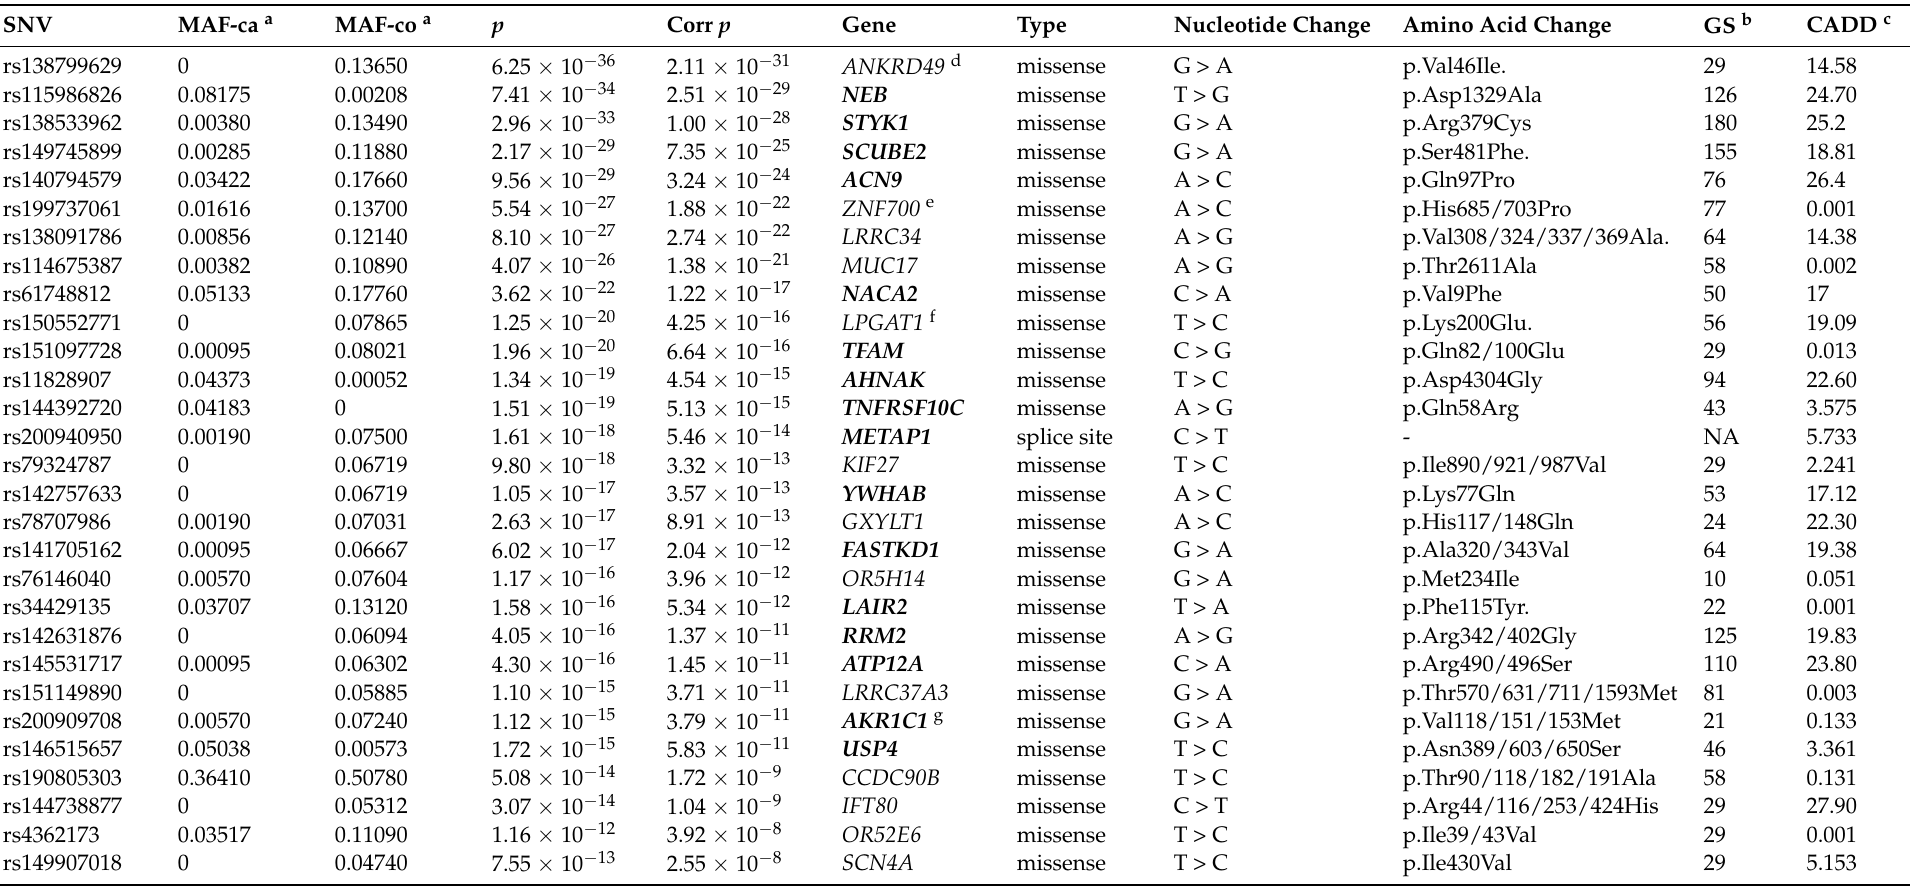
Table 2. Top 54 SNVs identified through our exome chip study. For each SNV, the minor allele frequencies in the POP cases and controls (MAF-ca and MAF-co), the p value of association with POP, and the Bonferroni-corrected p value are provided. All SNPs with Bonferroni-corrected p < 0.05 are listed. In addition, the affected gene, SNV type, nucleotide change, and amino acid change are indicated. If applicable and available, the Grantham and CADD scores—which are both predictive measures of pathogenicity—for each SNV are given. Further, the 26 genes encoding proteins within the molecular landscape of POP (Figure 1) are indicated in